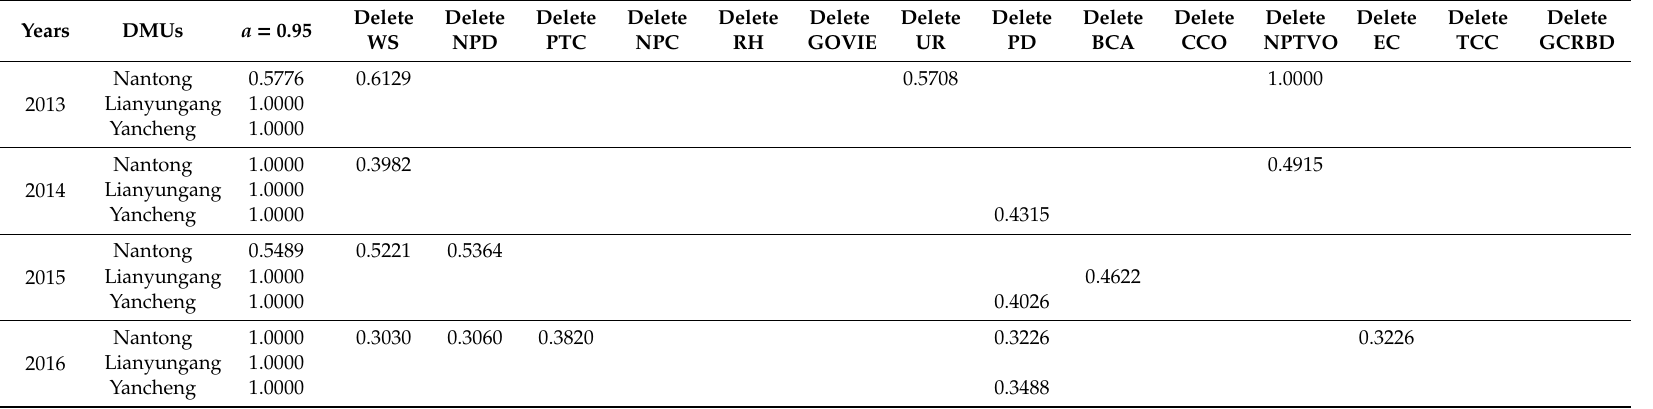
Table A16. The changes of stochastic e ffi ciency value by deleting single input variable in Coastal Area ( α =